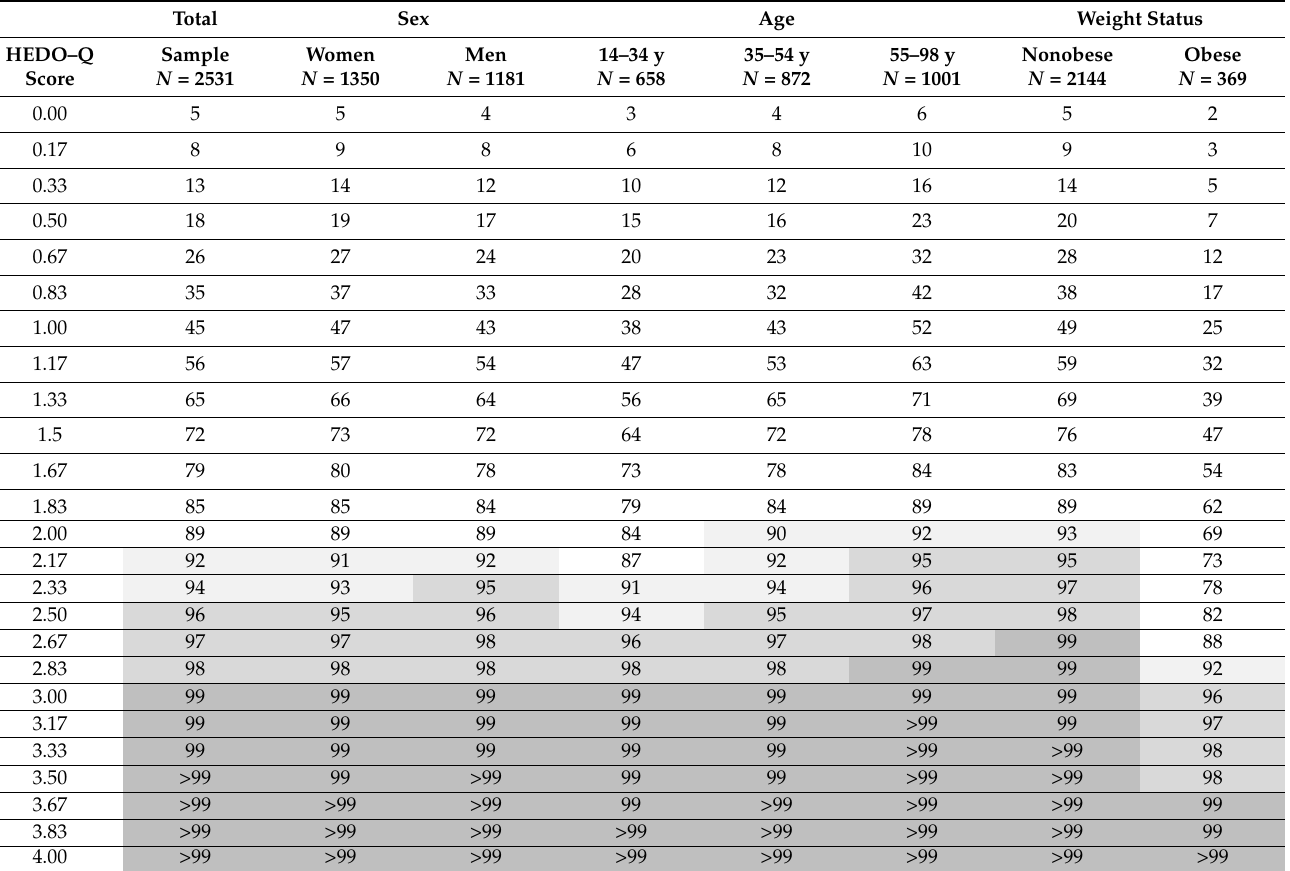
Table 4. Norms of the Hedonic Overeating–Questionnaire (HEDO–Q) in the total sample and in subsamples by sex, age, and weight